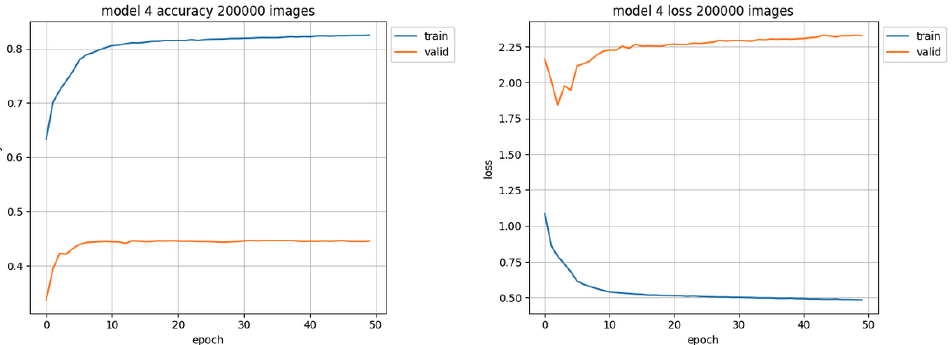
Figure 12. Training results using 200,000 images of the unleveled training set. The accuracy chart is presented on the left side, the loss value chart on the right